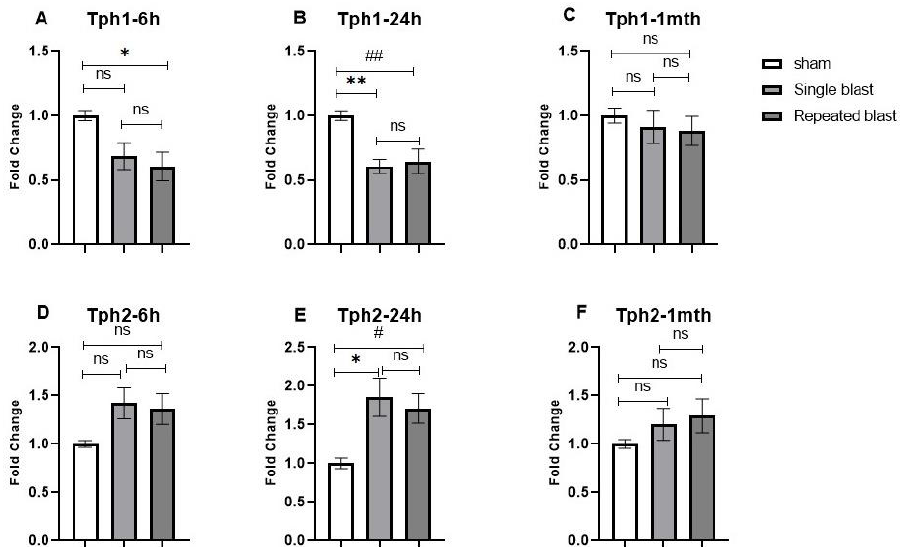
(Figure 3E) or 1 month postblast in either group in comparison to the sham rats (F (2, 15) = 1.102; p = 0.3576) (Figure 3F).